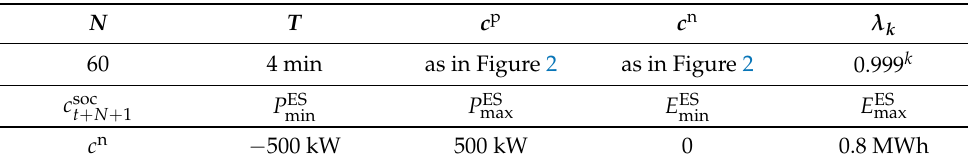
Table 1. PV+BESS plant and MPC control parameters.